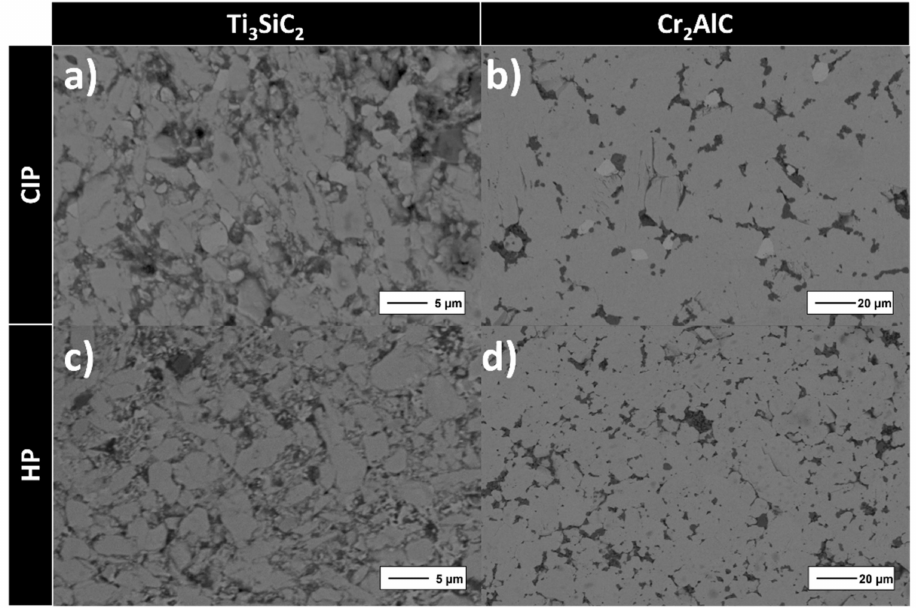
Figure 10. SEM micrographs of ( a ) cold isostatic pressed and sintered (CIP) Ti 3 SiC 2 ; ( b ) cold isostatic pressed and sintered (CIP) Cr 2 AlC; ( c ) hot-pressed (HP) Ti 3 SiC 2 and ( d ) hot-pressed (HP) Cr 2 AlC.